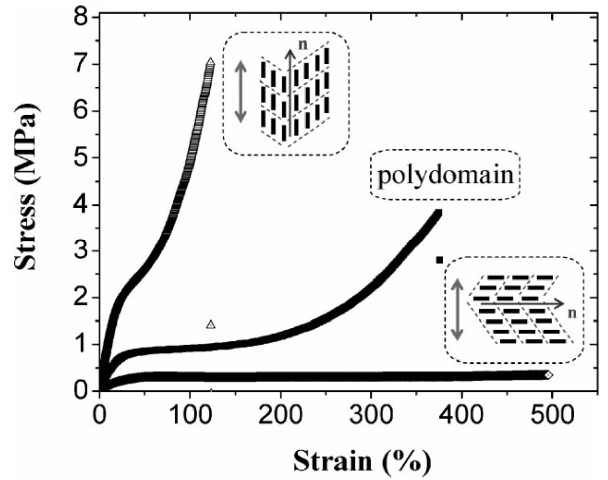
Figure 7. Real time stress-strain plot for LCE1 stretched parallel and perpendicular to the global director. Rate of elongation: 0.125 mm/s. These plots reveal directional dependence of the elastic modulus. The system is more (less) rigid in the case of parallel (perpendicular) stretching. Adapted with permission from [65]. Copyright 2008 John Wiley and